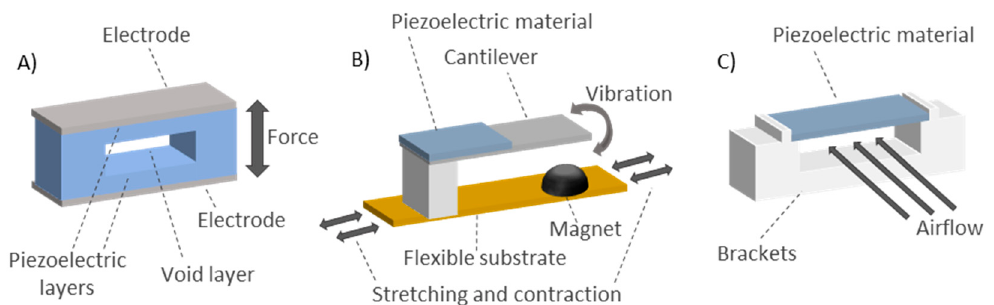
Figure 14. Piezoelectric energy harvesters. Three possible configurations are shown: ( A ) power generation based on compression or stretching movements associated with breathing (figure inspired by Reference [244]), ( B ) energy harvesting based on vibration amplified by a magnet (figure inspired by Reference [243]), and ( C ) technique using low speed airflow (figure inspired by Reference [245]).